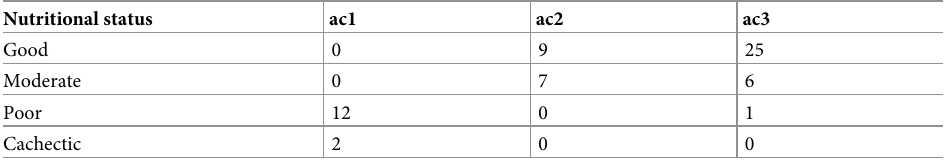
Table 1. Nutritional status of the investigated pheasants (number of pheasants).